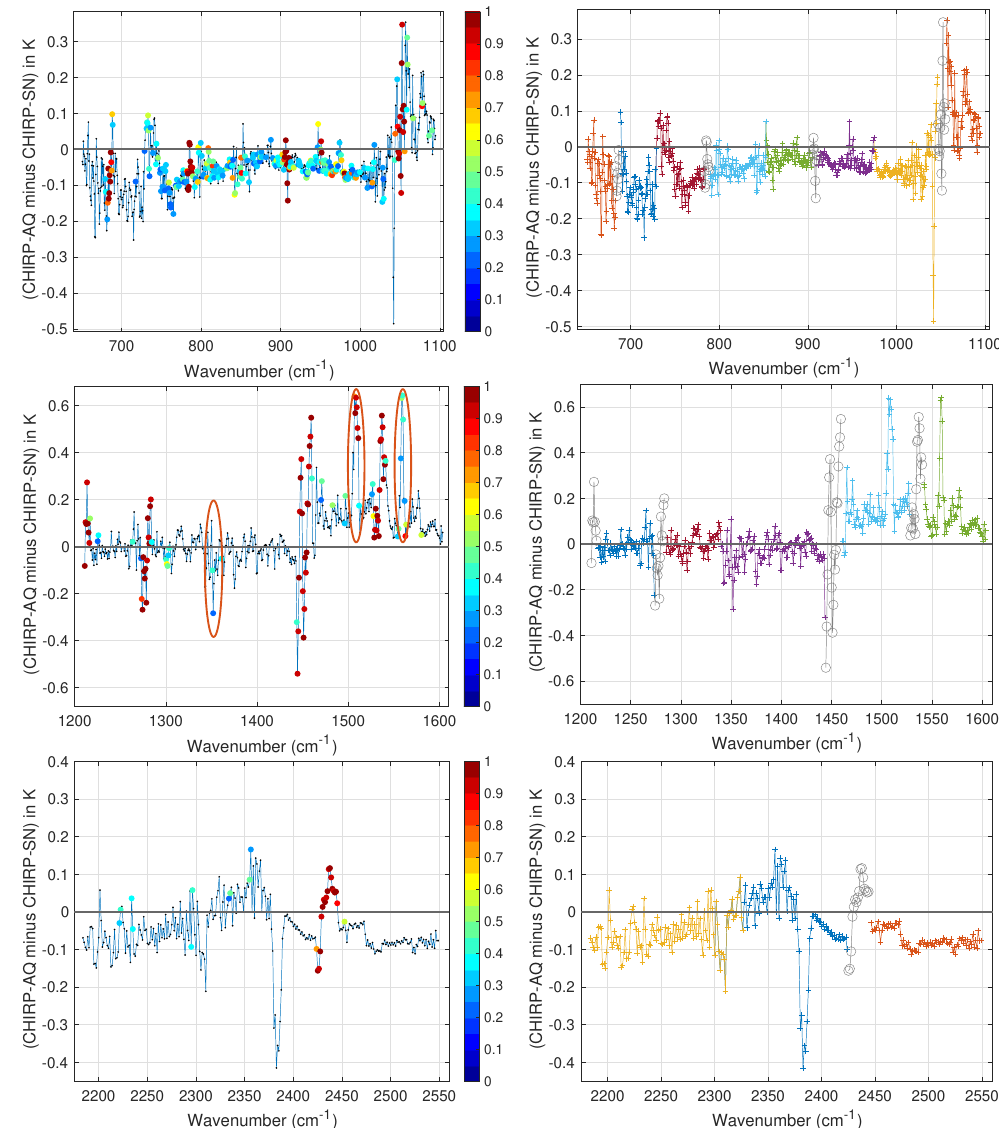
Figure 9. Zooms of Figure 8. The left and right columns show identical copies of the data from Figure 8. On the left any channel with synth_frac greater than 0.02 is highlighted with a circle whose color denotes the fractional value of CHIRP product synth_frac for that channel as defined in the colorbar. The right hand column highlights the AIRS module array colors used to generate those CHIRP channel (same colors as in Figure 8) as well as the wavenumber locations of AIRS L1c fill channels (gray lines and circles). Red circles for the midwave, left column, indicate regions with high fill values located where AIRS L1c channels exist, but are very noisy or contain dead